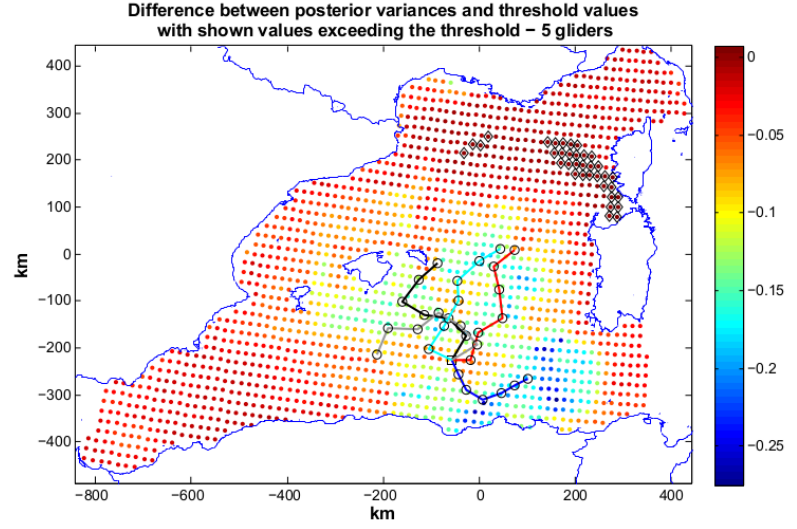
Figure 8. Scenario 2: planned paths for five gliders. The solution is characterized by J η = 0.09 ( J c = 2.06). In the figure we also show the difference between posterior variances and relative values of the objective threshold. Black markers toward the north-east part of the operative area indicate locations whose posterior is still above the required threshold. The use of five gliders is considered satisfying, since we are quite close to the achievement of our goal (no black